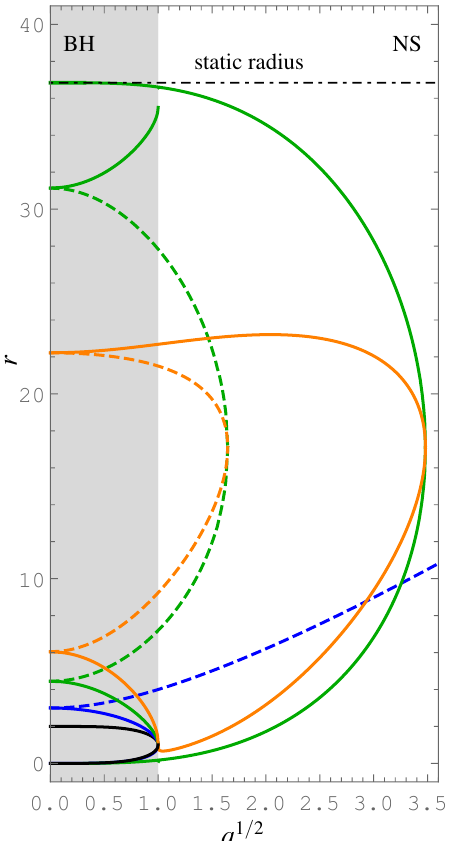
Figure 5. Mutual positions of astrophysically important circular orbits of the Kerr–de Sitter spacetime. The figure is constructed for the representative value of y = 2 10 − 5 . The radii of special equatorial × circular orbits are plotted as functions of the rotational parameter a . The shaded region determines the black-hole (BH) part of the spacetime and the rest corresponds to the naked-singularity (NS) part. Solid curves are used for the plus-family orbits (in most cases, they correspond to the corotating orbits from the point of view of the locally nonrotating observers, but there are exceptions described in the text), while the dashed curves are used for the minus-family orbits (in all spacetimes under consideration: counterrotating orbits). Black curves determine the inner and outer black-hole horizons. Blue curves determine the photon circular orbits. Green curves determine the marginally bound circular orbits (there is a disconnection between BH and NS regions for the plus-family orbits). Orange curves determine the marginally stable